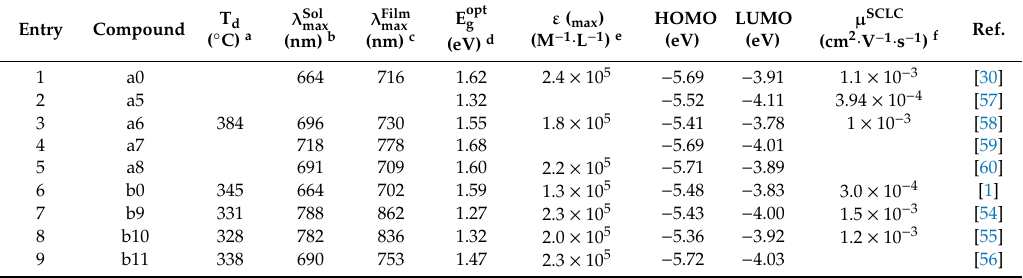
Table 3. Optical and electrochemical properties of acceptors a5–a8 and b9–b11.